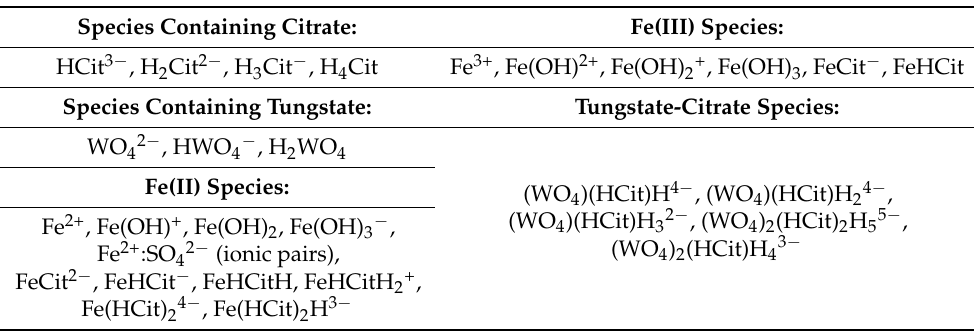
Table 1. The list of species formed in the solution and considered for calculations at pH 6.9 after dissolving FeSO 4 , Na 2 WO 4 , sodium citrate and citric